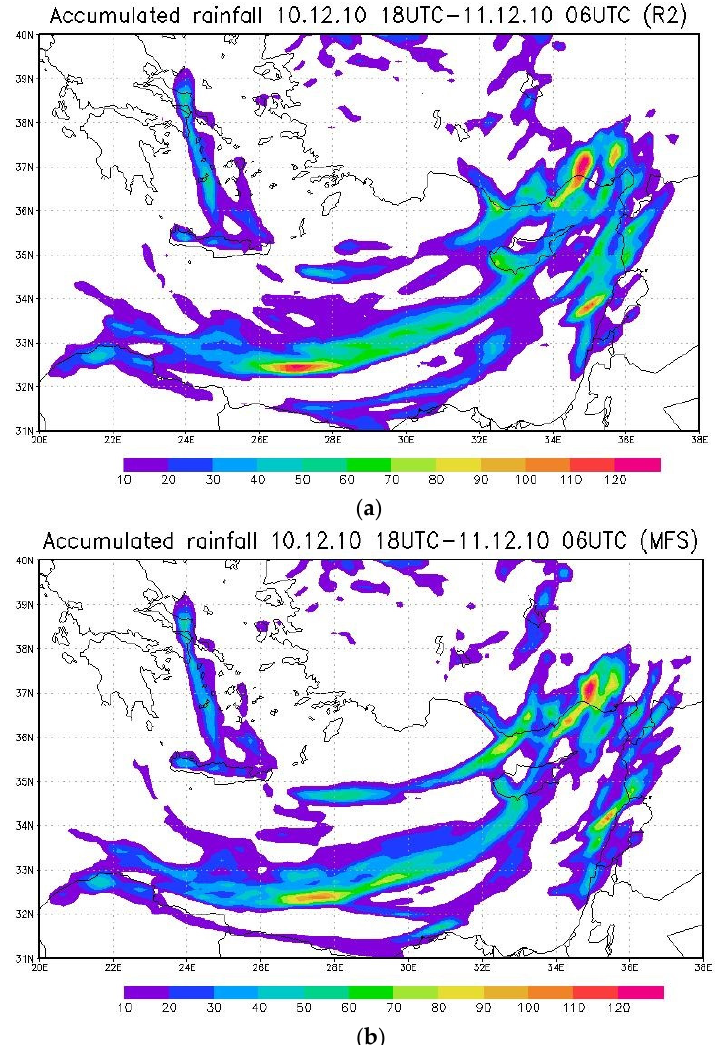
Figure 25. 12 Hour accumulated rainfall (mm) from 10 December 2010 18 UTC to 11 December 2010 06 UTC for ( a ) the R2 run ( b ) the MFS run.